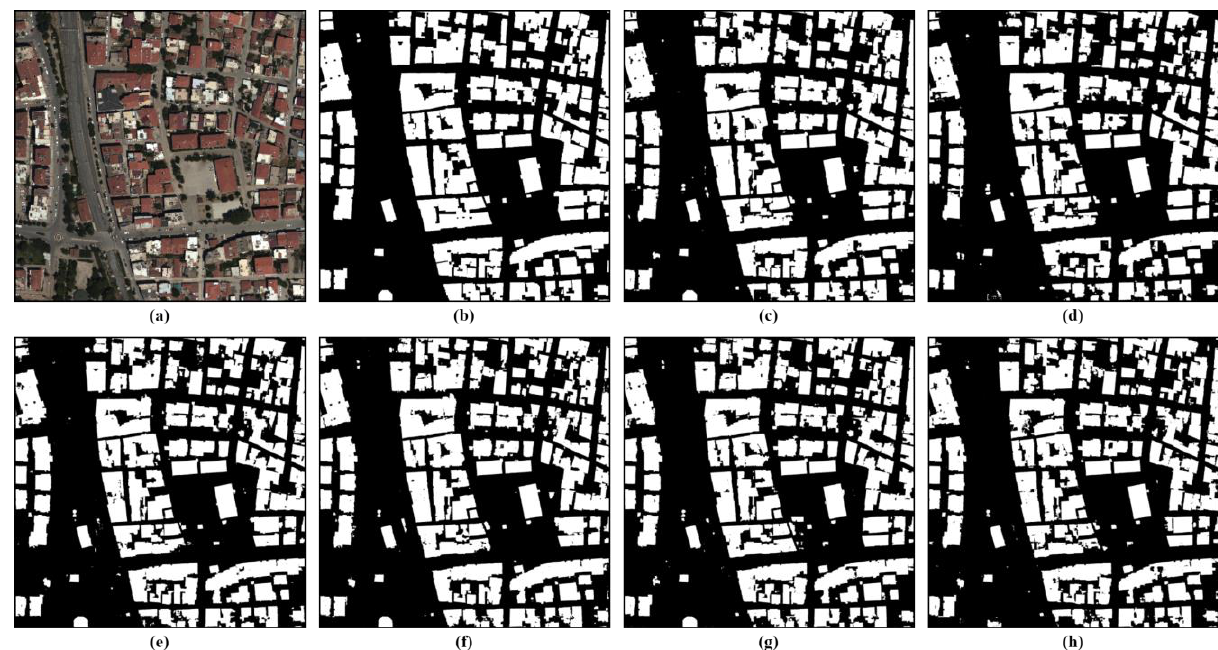
Figure 4. An overview of the RGB only predictions for the test area: (a) True orthophoto, (b) Ground truth, (c) U-Net+ResNet-18, (d) U-Net+ResNet-50, (e) U-Net+SeResNet-18, (f) LinkNet+ResNet-18, (g) LinkNet+ResNet-50 and (h)